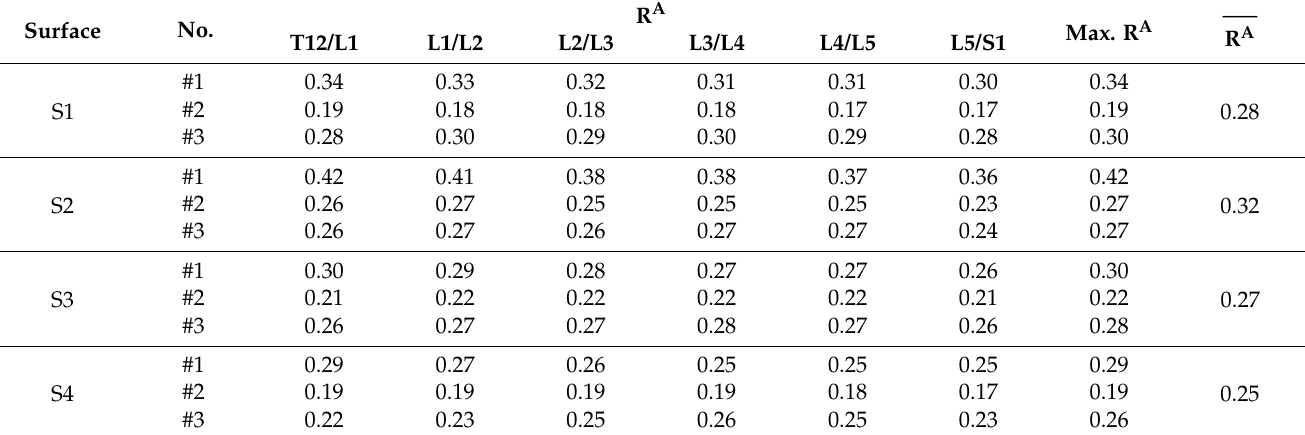
Table 11. Summary of data obtained from driver 2 according to ISO 2631-5:2018, Factor R A .